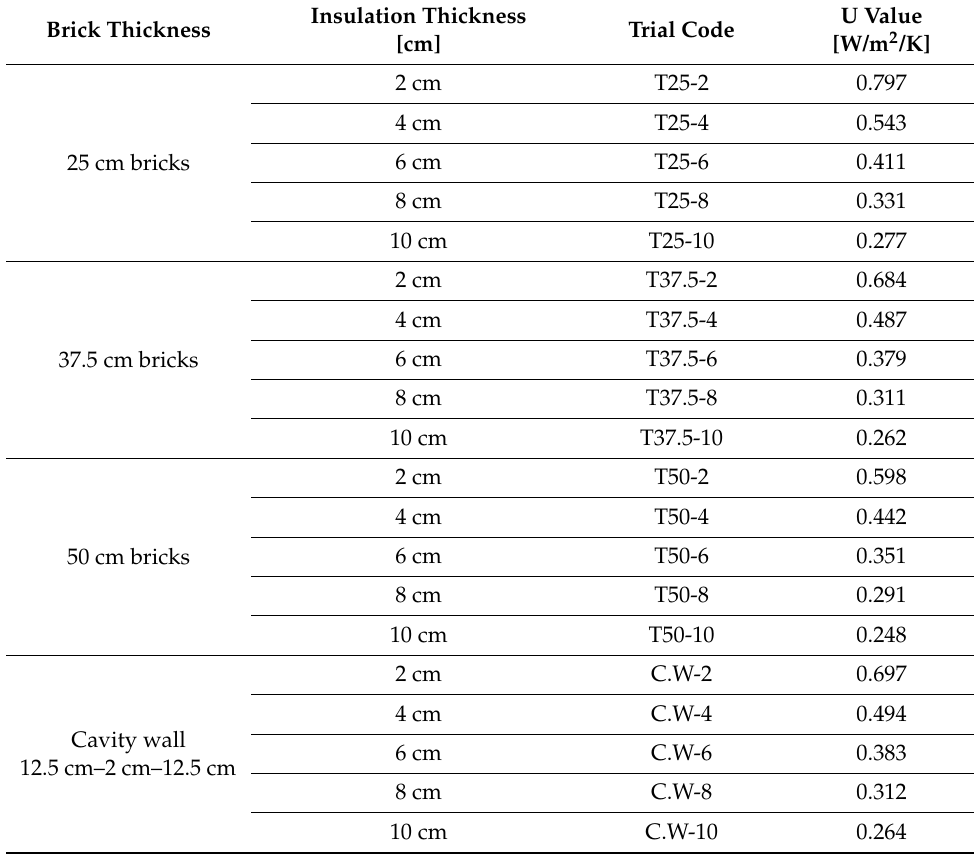
Table 3. List of all the external wall alternatives.